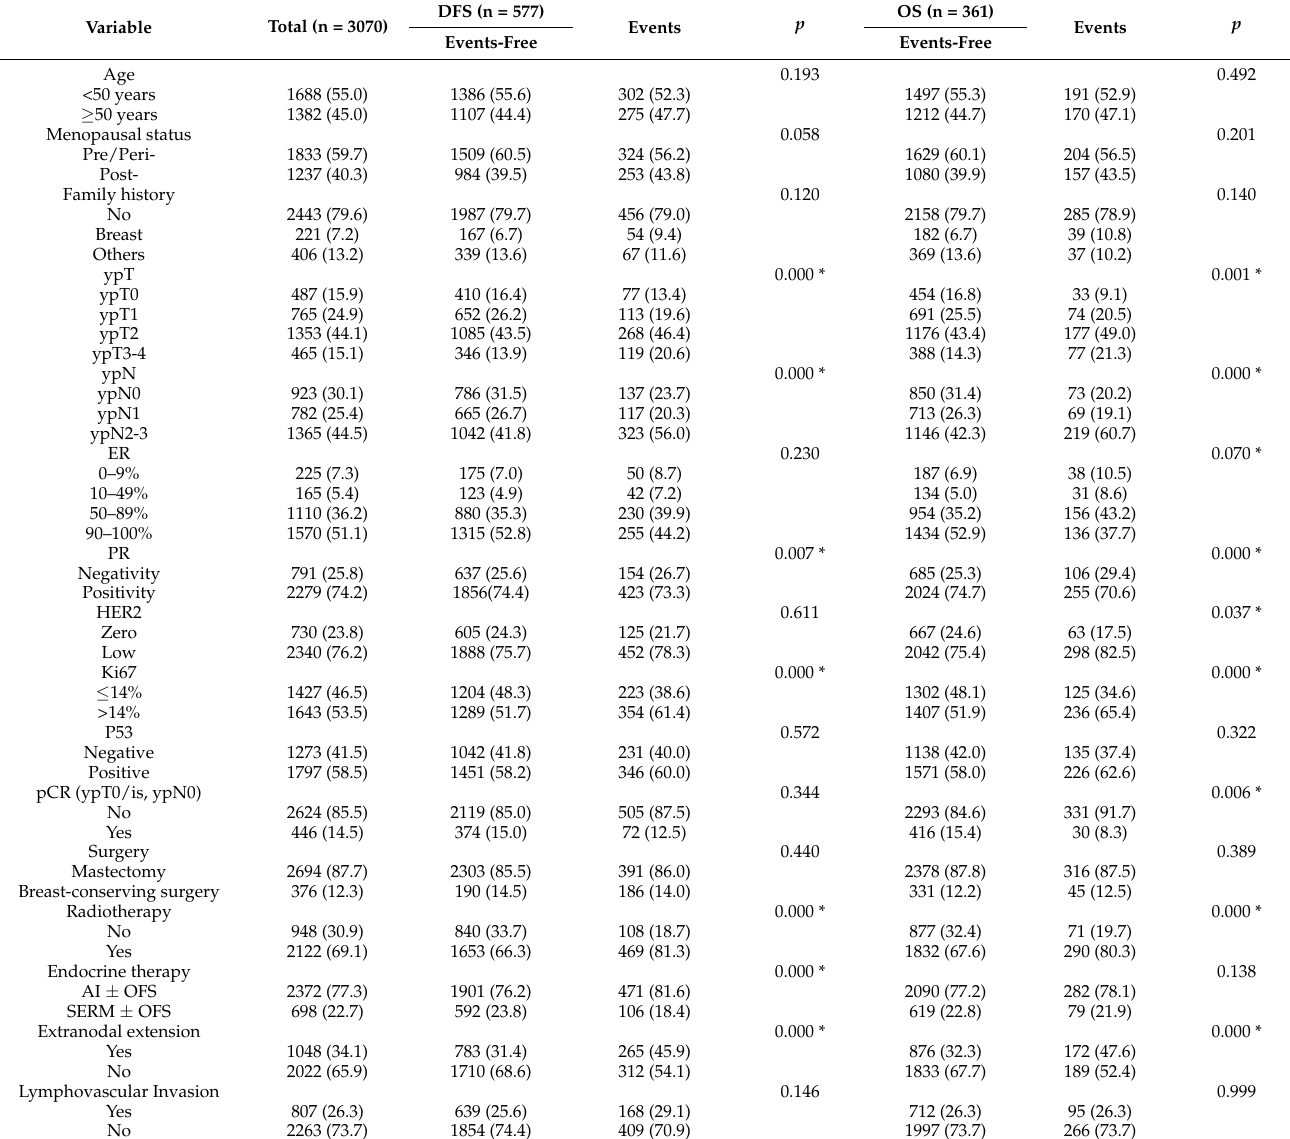
Table 1. Baseline patient characteristics and log rank test of DFS and